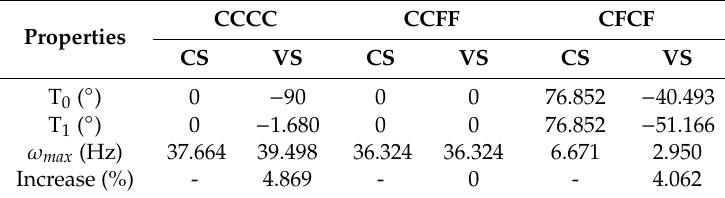
Table12. OptimalanglesofasinglelayerVSplateformaximumfundamentalfrequency(Hz),withclamped boundary conditions.